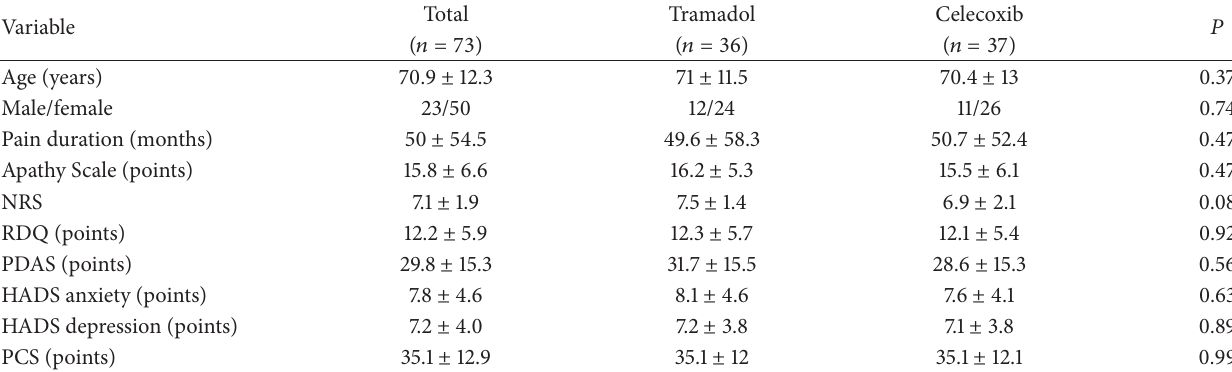
Table 1: Patients’ demographics.